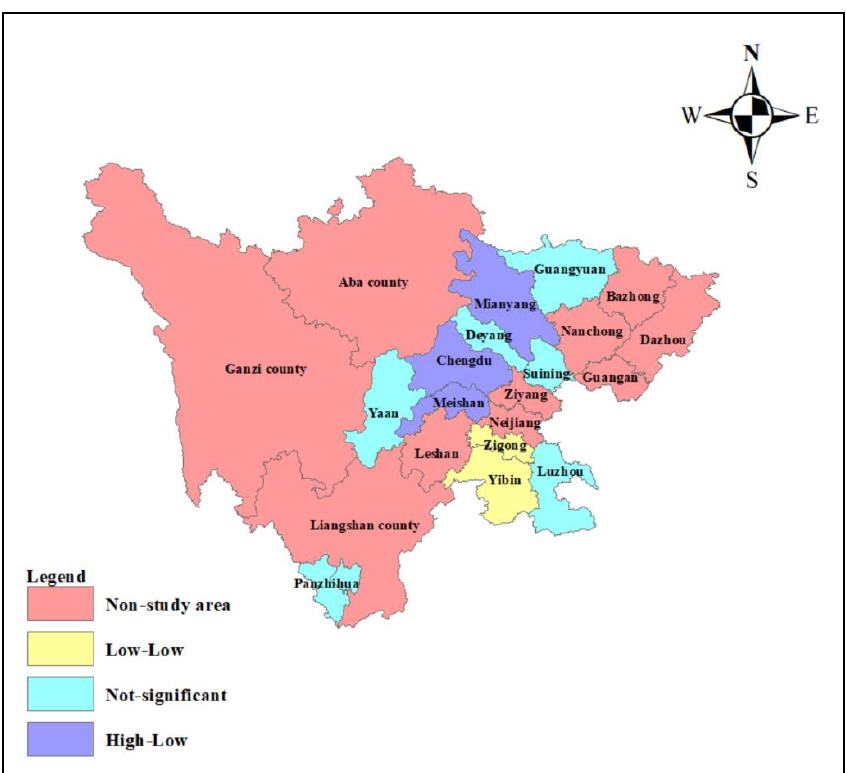
Figure 13. LISA aggregation diagram of the 11 counties’ CGLUE in 2015 .